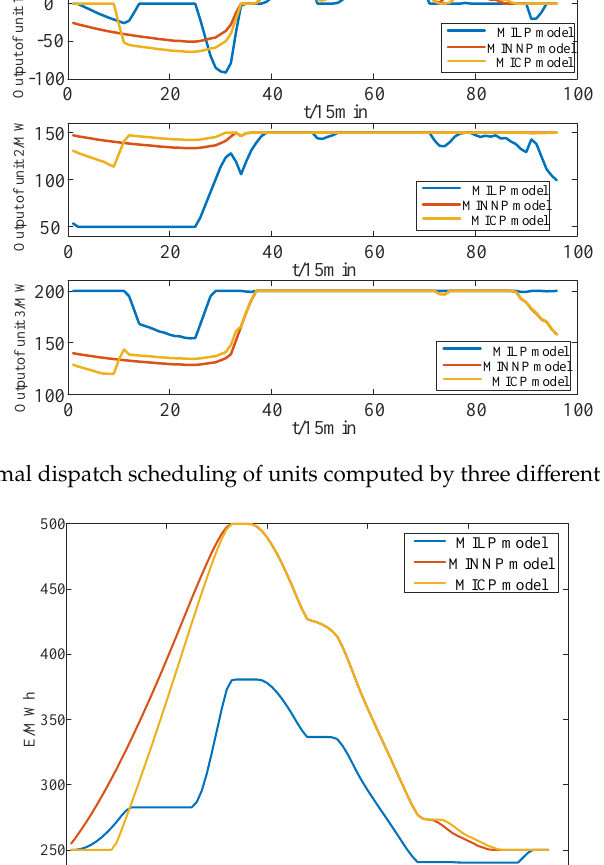
Table 4. Comparison of the results. SCUC Model